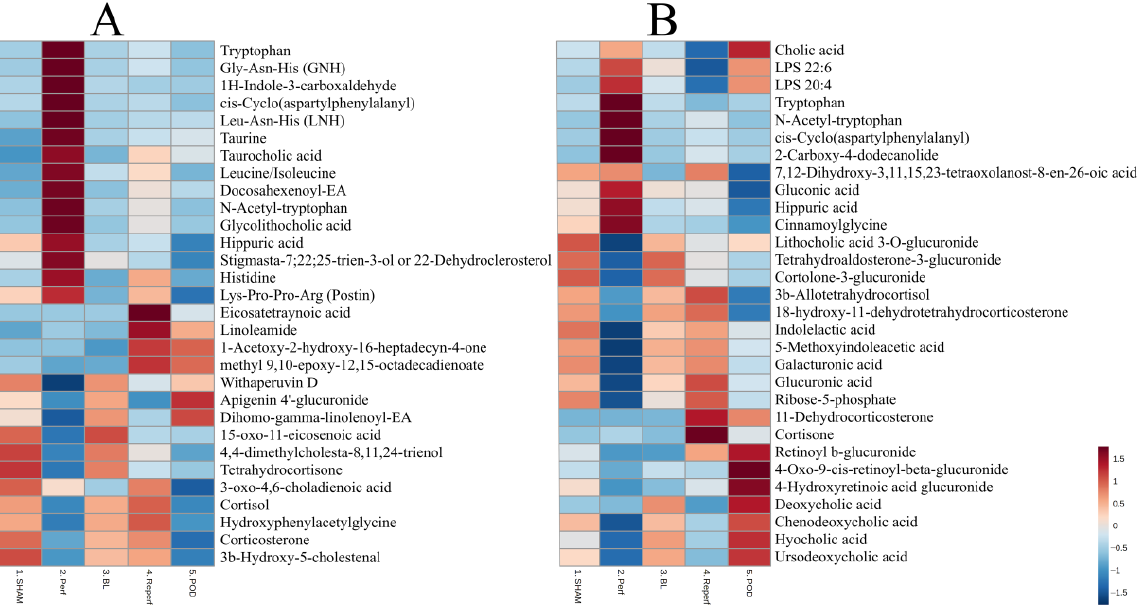
Figure 2. Heatmap showing the overall levels of the metabolites differentiating the samples collected at each time interval (Ward’s clustering algorithms, Euclidean distances). ( A ) Positive ionization mode, ( B ) negative ionization mode. The dark red squares on the heat map indicate a high abundance of that feature in a specific group of samples, whereas dark blue indicates a low